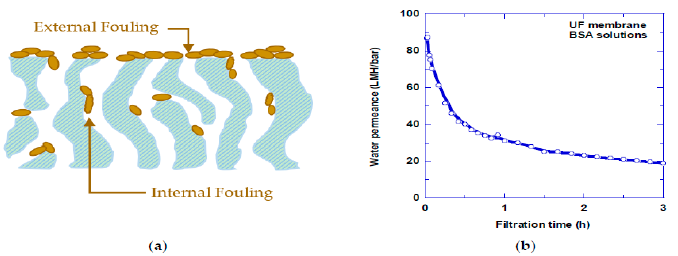
Figure 26. (a) Diagram of exterior and interior membrane fouling. [288]. Figure 26. ( a ) Diagram of exterior and interior membrane fouling